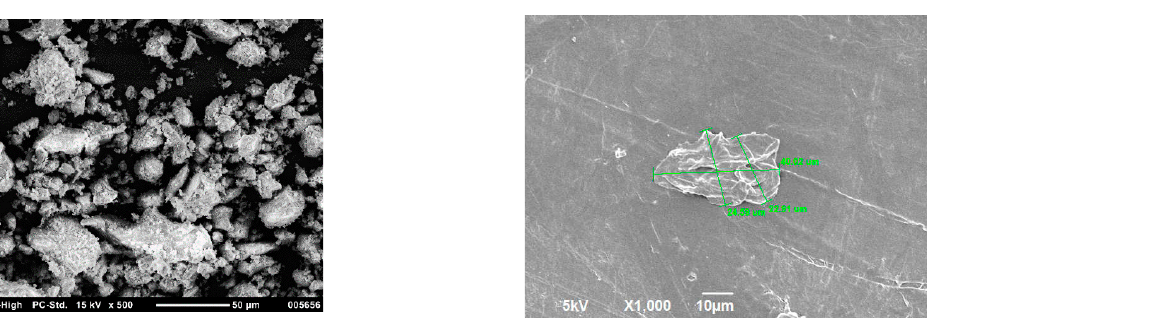
Table 5. SEM images of 25 µ m, 5 µ m, 0 wt%, and 35 wt% were prepared from both particle sizes.